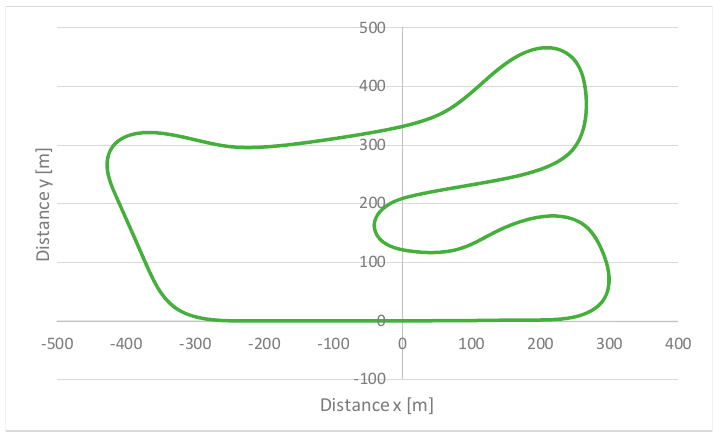
Figure 21. The Hockenheim short track map.